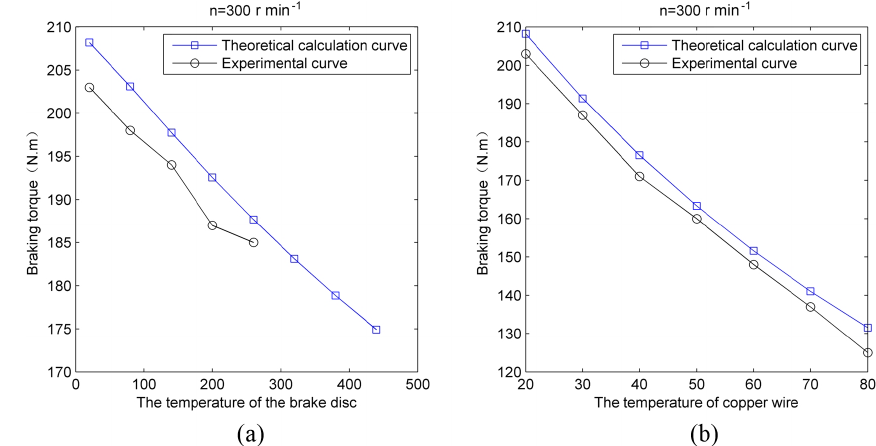
Figure 7. Braking torque curves varies with